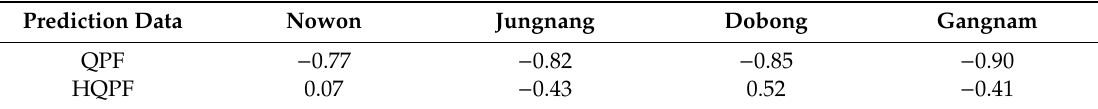
Table 7. NPE (mm / 3 h) calculated at four sites from QPF-based rainfall and HQPF-based rainfall with respect to a heavy rainfall event in Seoul (section